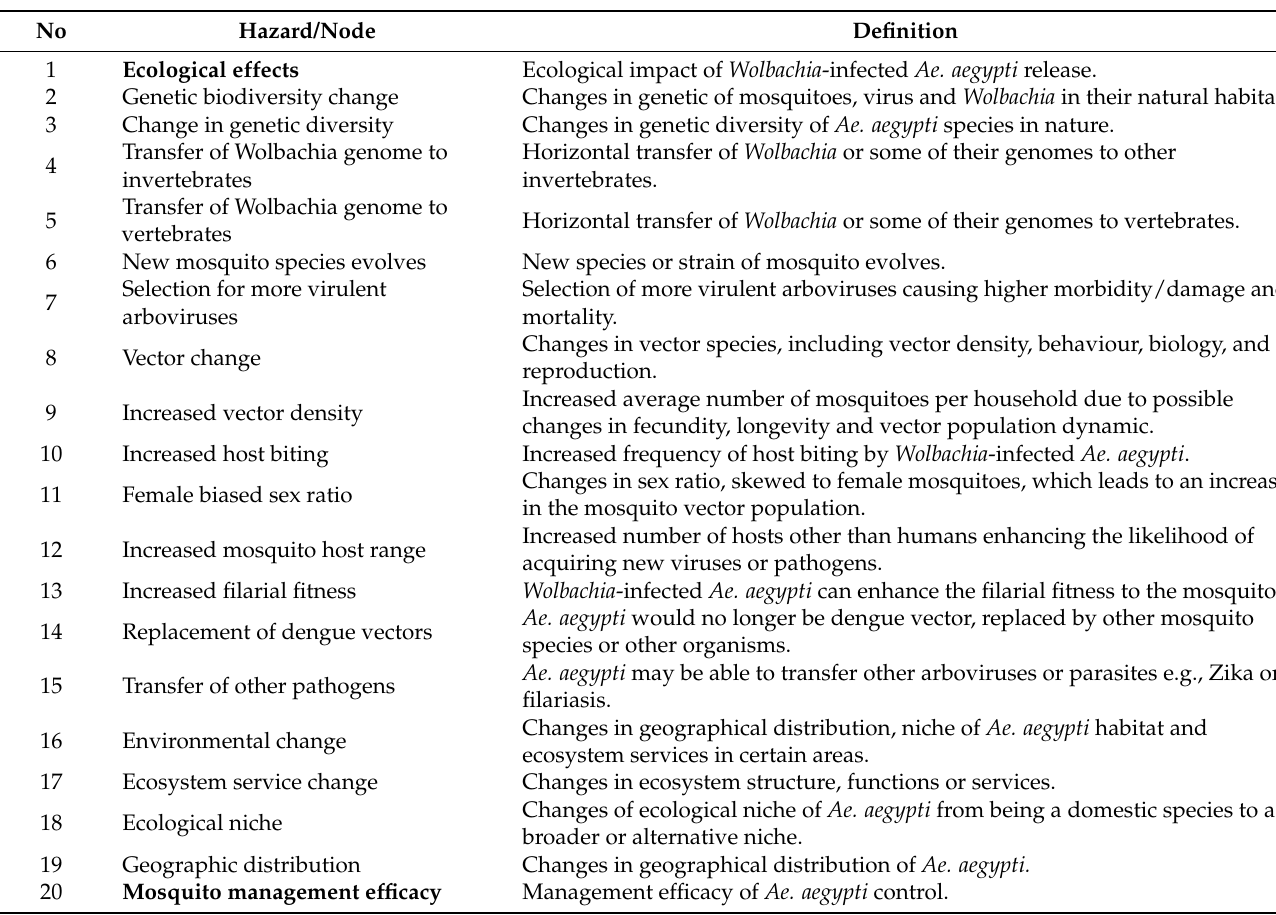
Table 1. Definition of identified hazards that may “cause more harm” upon the release of Wolbachia - infected Aedes aegypti within a 30-year time